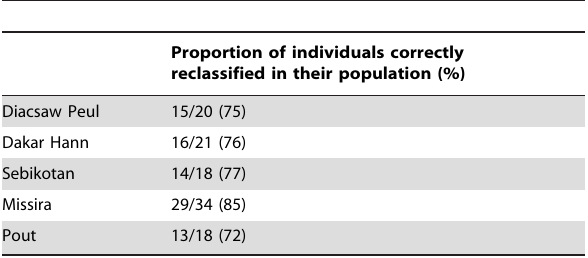
Table 3. Geometric morphometrics: reclassification scores of individuals in their population of